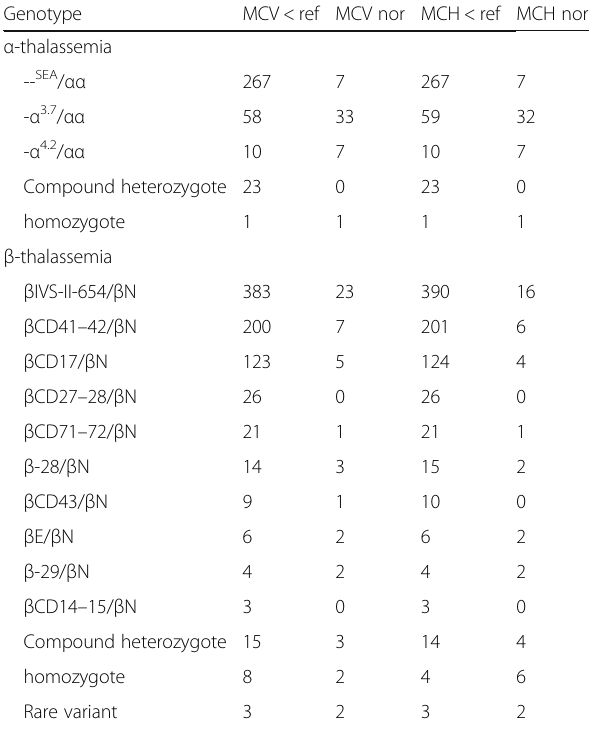
Table 2 Genotype and hematologic data of thalassemia patients